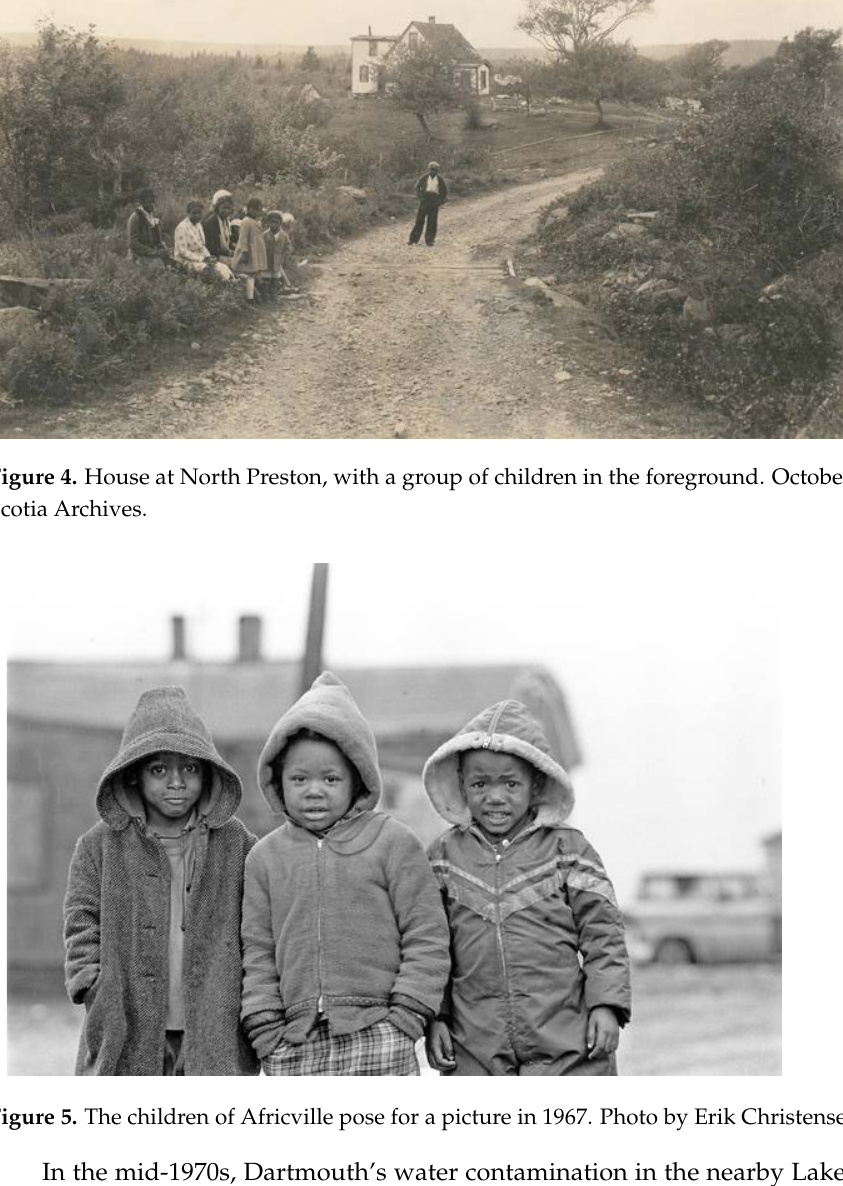
Figure 4. House at North Preston, with a group of children in the foreground. October 1934. Nova Scotia Archives.